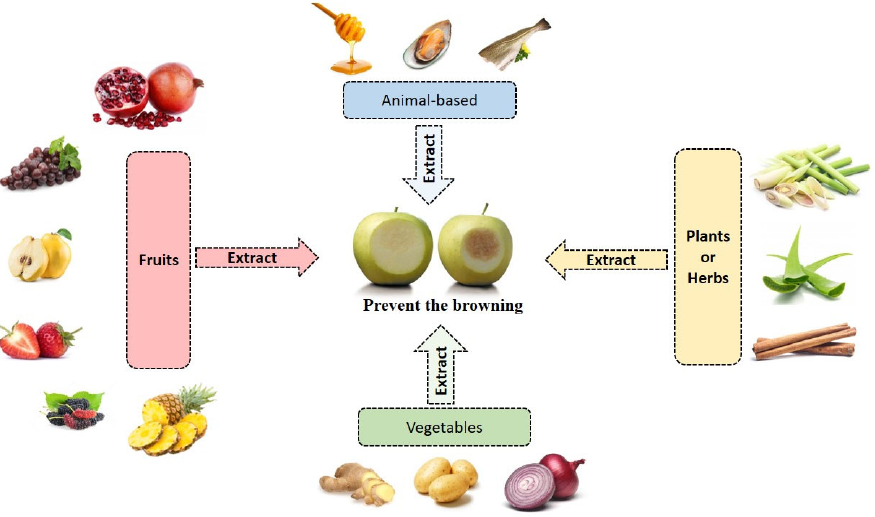
Figure 1. Natural extracts from fruits, vegetables, plants or herbs, and animal ‐ based resources for preventing browning